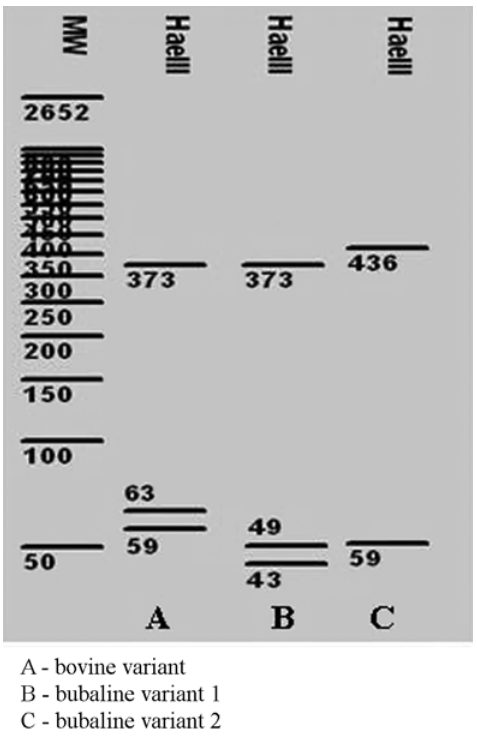
Figure 3 - Virtual analysis of Hae III-RFLP products of the CSN2 exon VII,usingthesoftwarepDRAW32onthesequencesof(A)bovineand(B) bubaline variants obtained from GenBank; (C) bubaline restriction pattern obtained in this